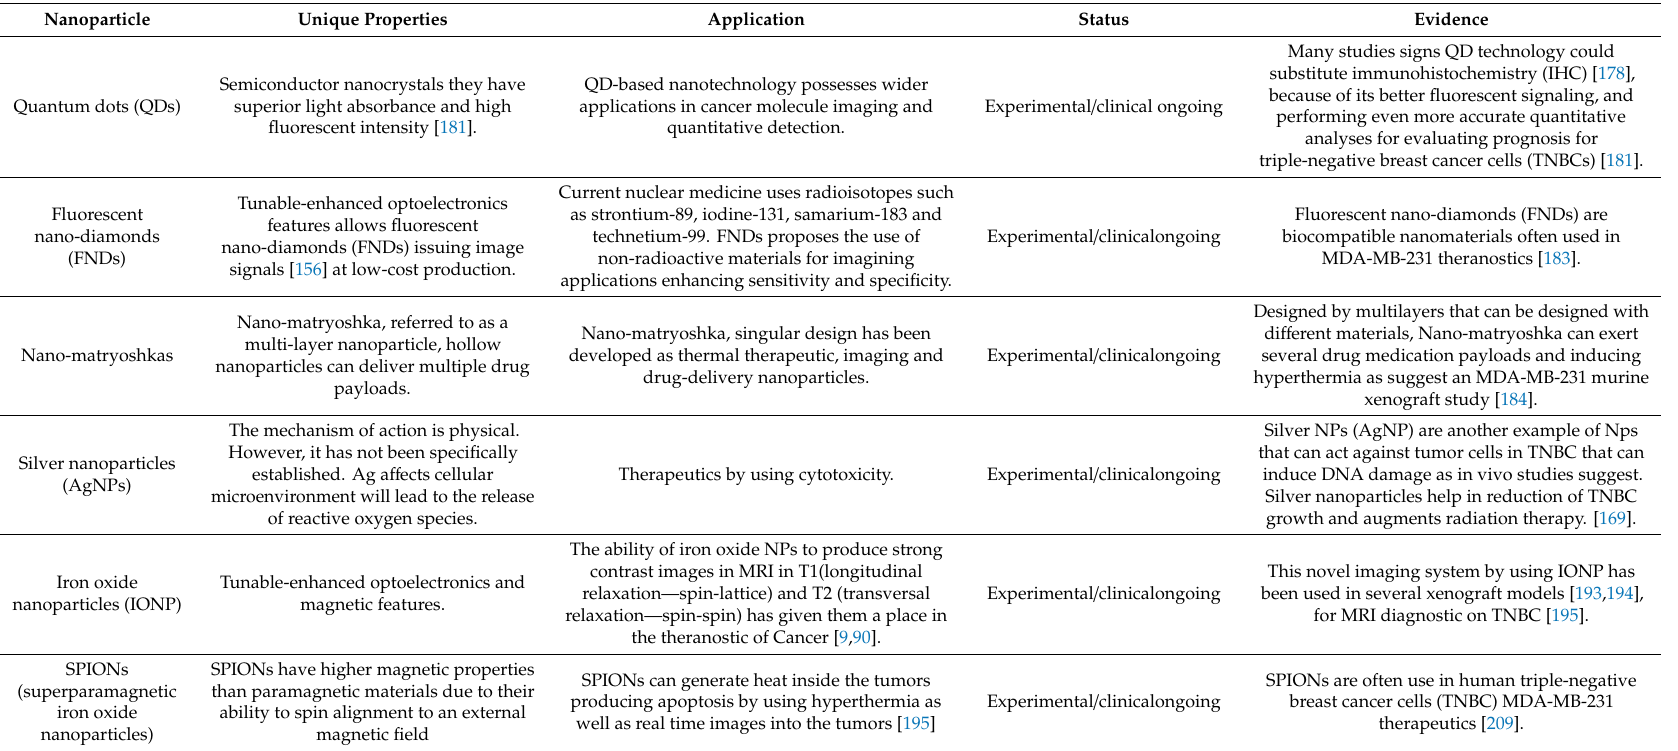
Table 2. Nanomedicine for triple negative breast cancer